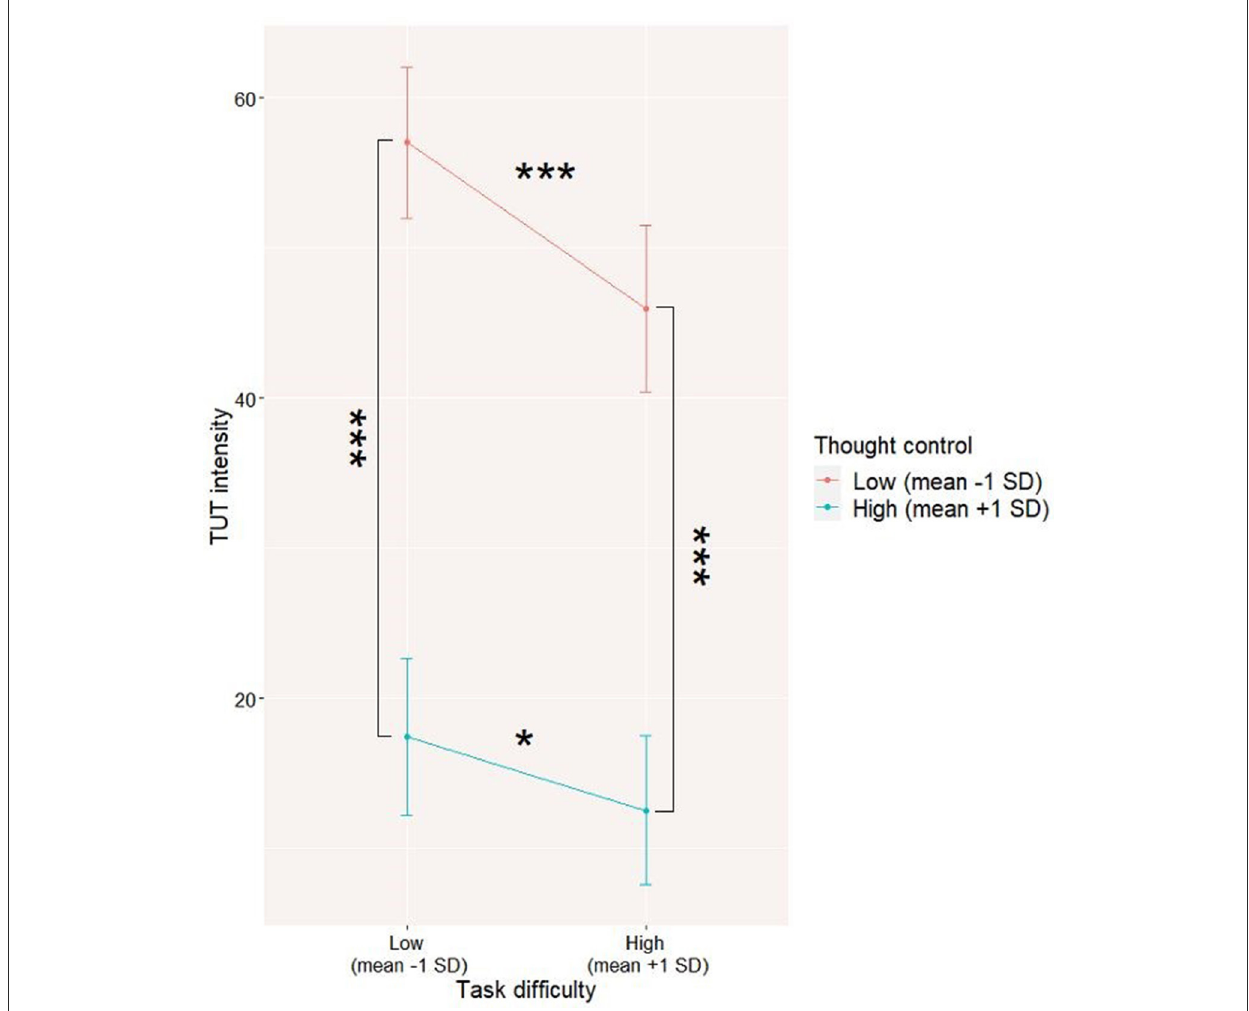
FIGURE1 Level 1 interaction between thought control and task difficulty on task-unrelated thoughts (TUT) level. The interaction was visualized by computing slopes for high (mean + 1SD) and low (mean-1SD) levels of predictor and moderator. * p < 0.05; *** p <